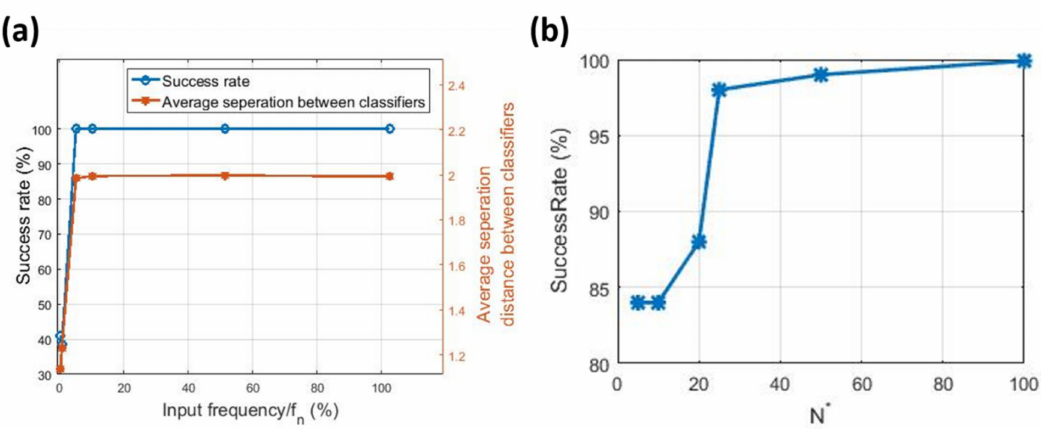
Figure 4. ( a ) Classifier accuracy as a function of the input frequency. At low input frequencies, the classifier fails to classify the input signal. However, as the frequency increases, the reservoir prediction accuracy increases to > 99%. ( b ) MEMS RC classification performance at f / f n = 20% when di ff erent N are